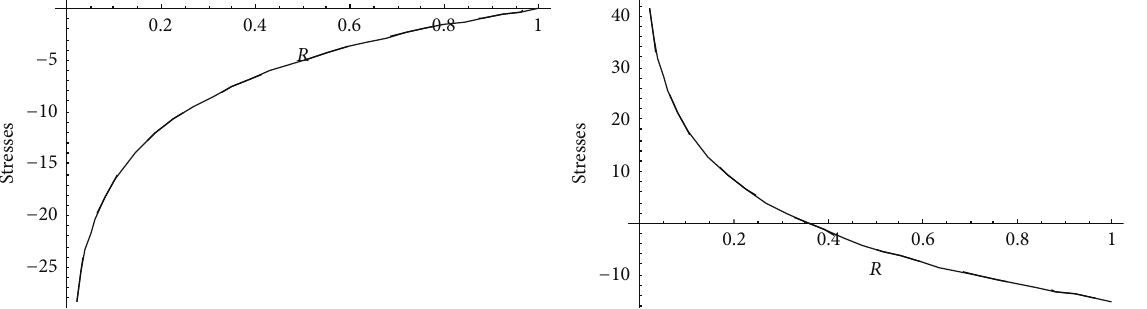
Figure 13: Homogeneous fully plastic stresses for a thick-walled circular cylinder under internal ( 𝑃 1 = 5 ) and external pressure ( 𝑃 2 = 0 and 15).